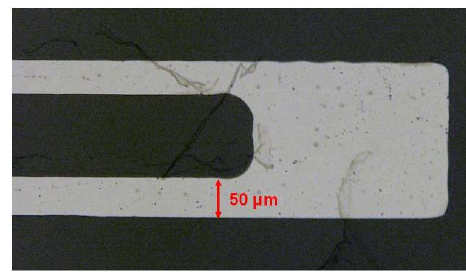
Figure 2. Detail of a structured sensor